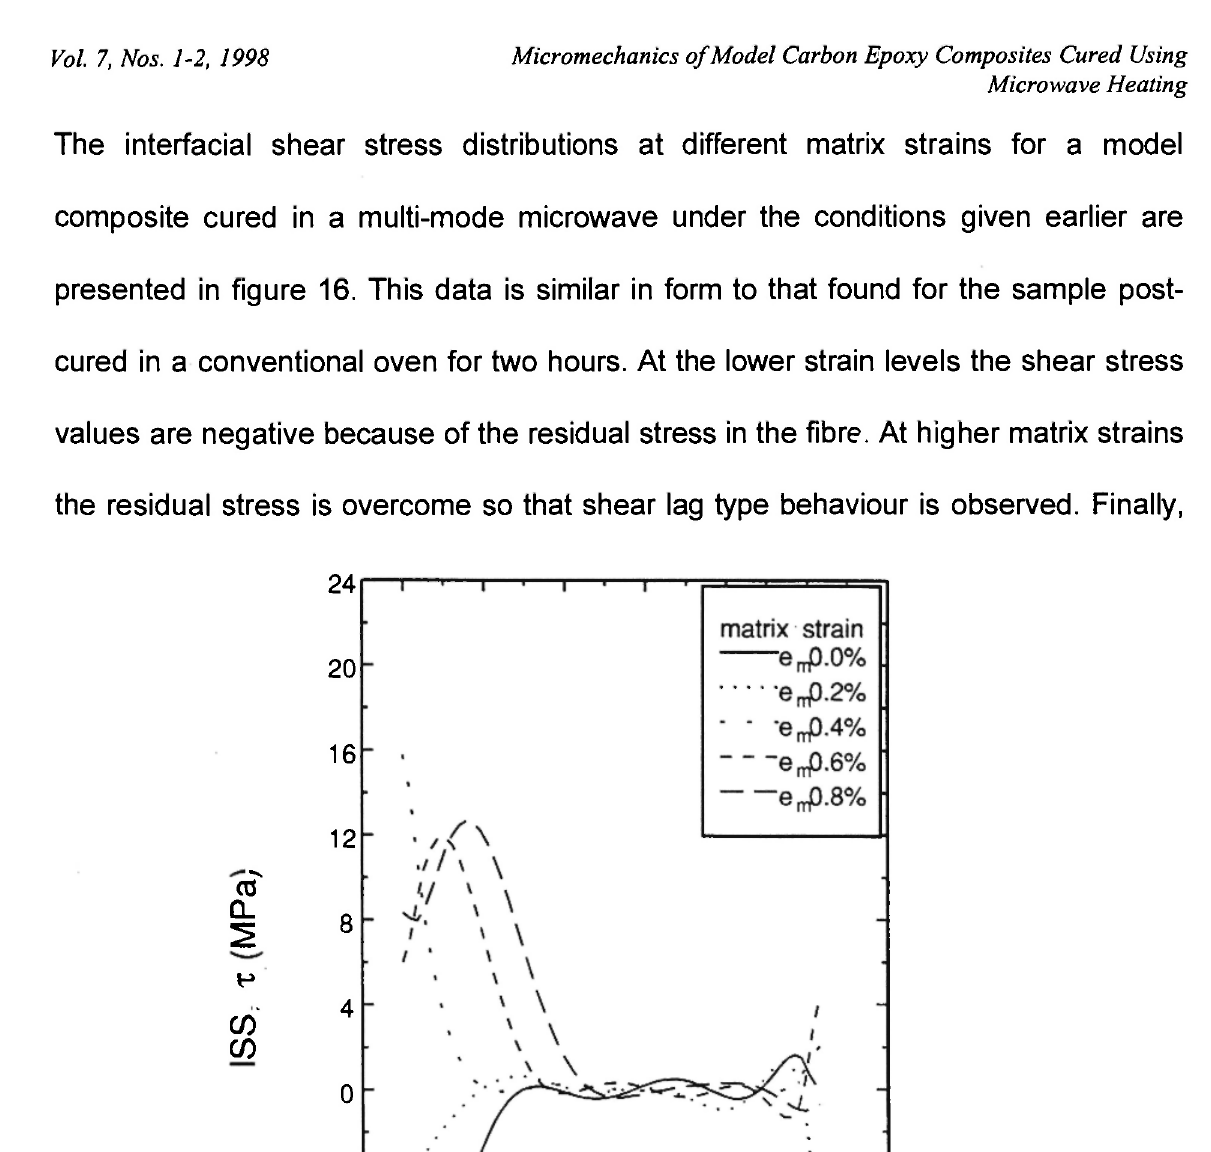
Figure 16. Interfacial shear stress versus position along the fibre from the cut end as a function of matrix strain for a single fibre model composite cured in the microwave oven using the conditions described in the